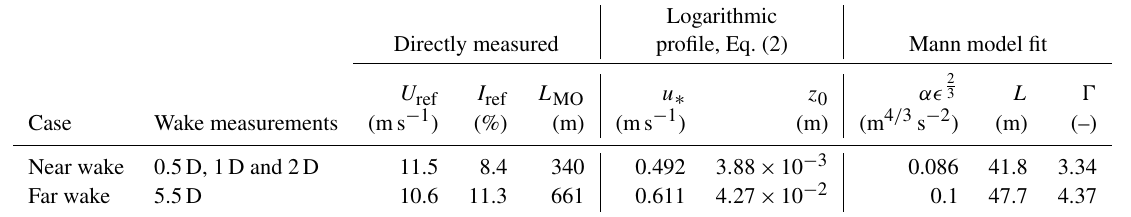
Table 1. Summary of test cases based on wake measurements and corresponding input parameters for numerical computations. Logarithmic Directly measured profile, Eq. (2) Mann model